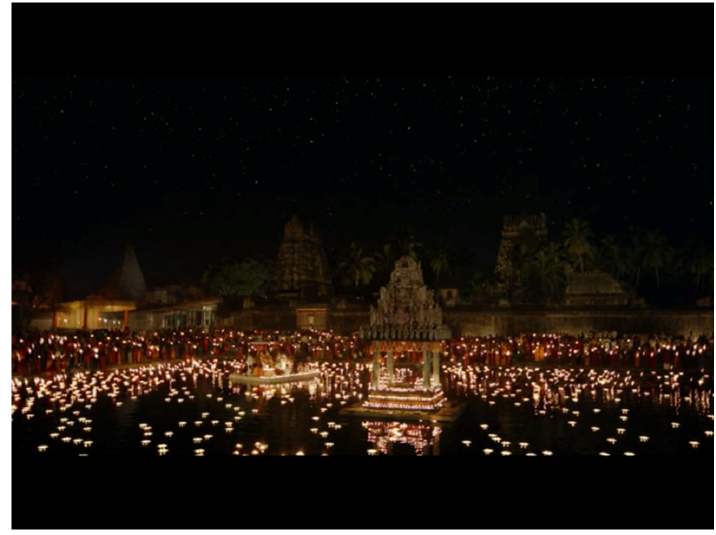
Figure 3. Ang Lee’s ritual at the Sri Gokilambal Thirukameshwara Temple in Villianur, India.